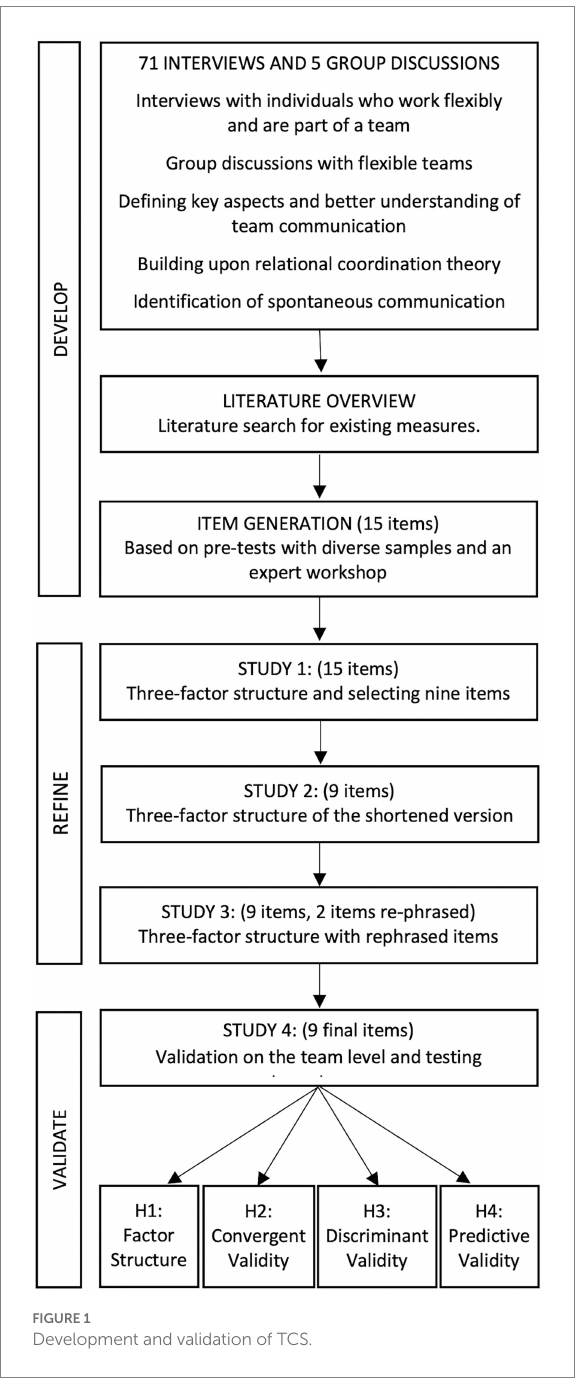
FIGURE 1 Development and validation of